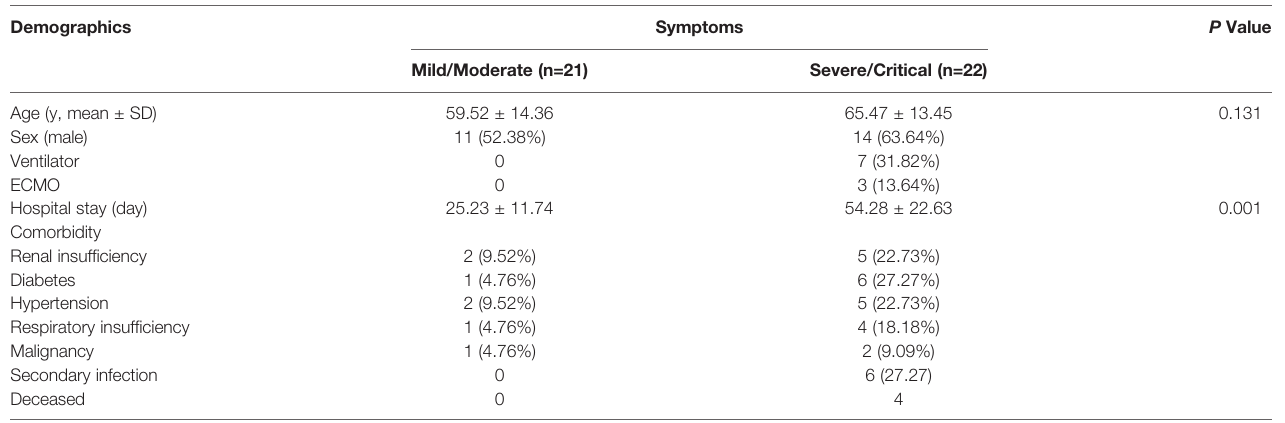
TABLE 1 | Demographics of